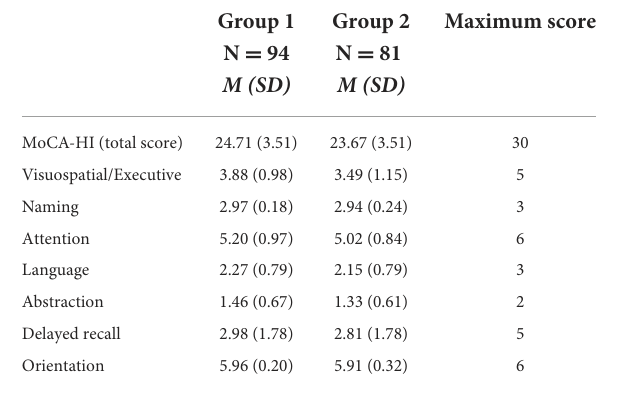
TABLE 2A Mean score in MoCA-HI and the different cognitive subdomains in Group 1 and Group 2.